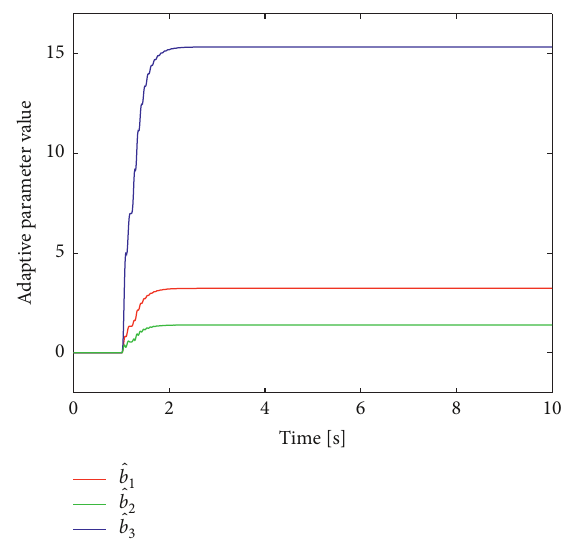
Figure 12: Time history of the adaptive parameters 􏽢 b